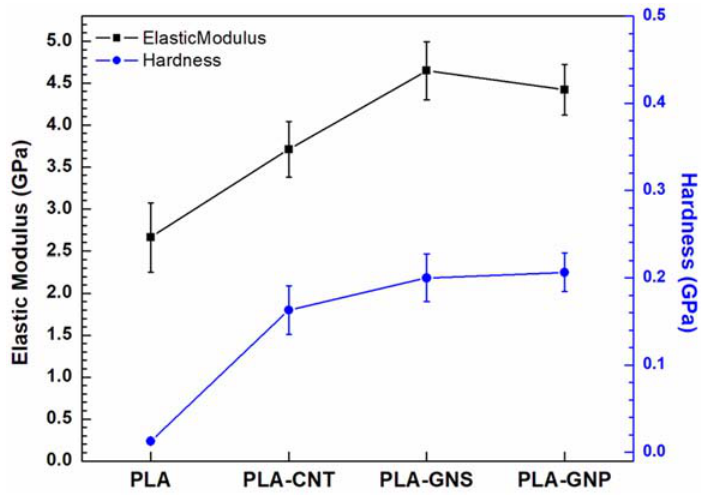
Figure 4. Elastic modulus and hardness curves of pure PLA and its hybrids with various nanoparticles via the nanoindentation test.